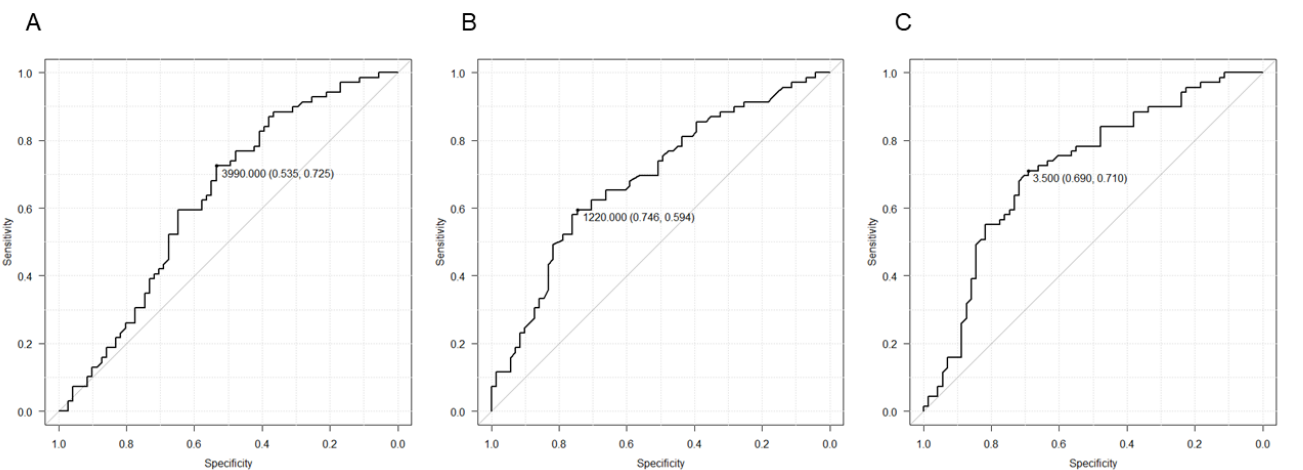
Figure 2. Receiver operating characteristic (ROC) curves for baseline absolute neutrophil count ( A ), absolute lymphocyte count ( B ), and neutrophil-to-Lymphocyte ratio ( C ).